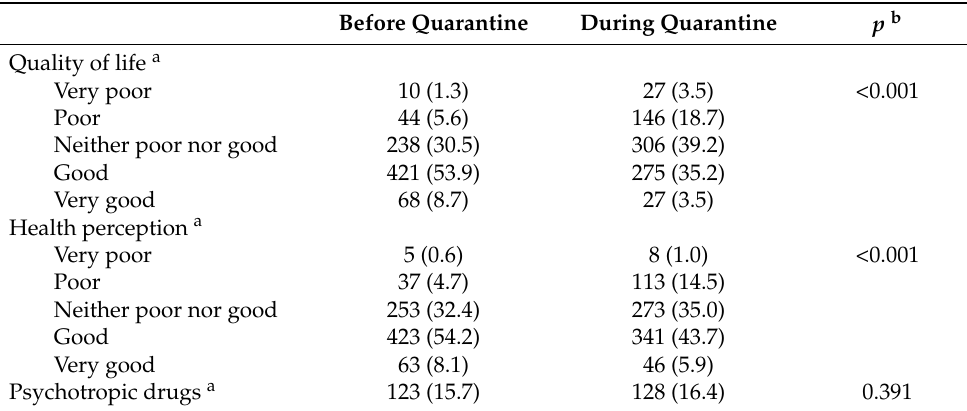
Table 4. Quality of life and health perception in the studied population. Before Quarantine During Quarantine p